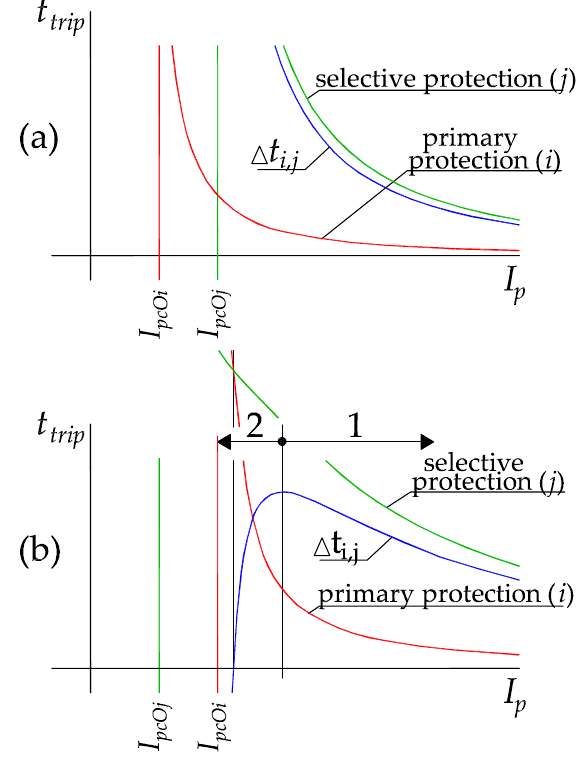
Figure 3. Possible pickup current choices in radial system without distributed generation. ( a ) Pickup current of selective protection is higher than the primary; ( b ) Pickup current of primary protection is higher than the selective